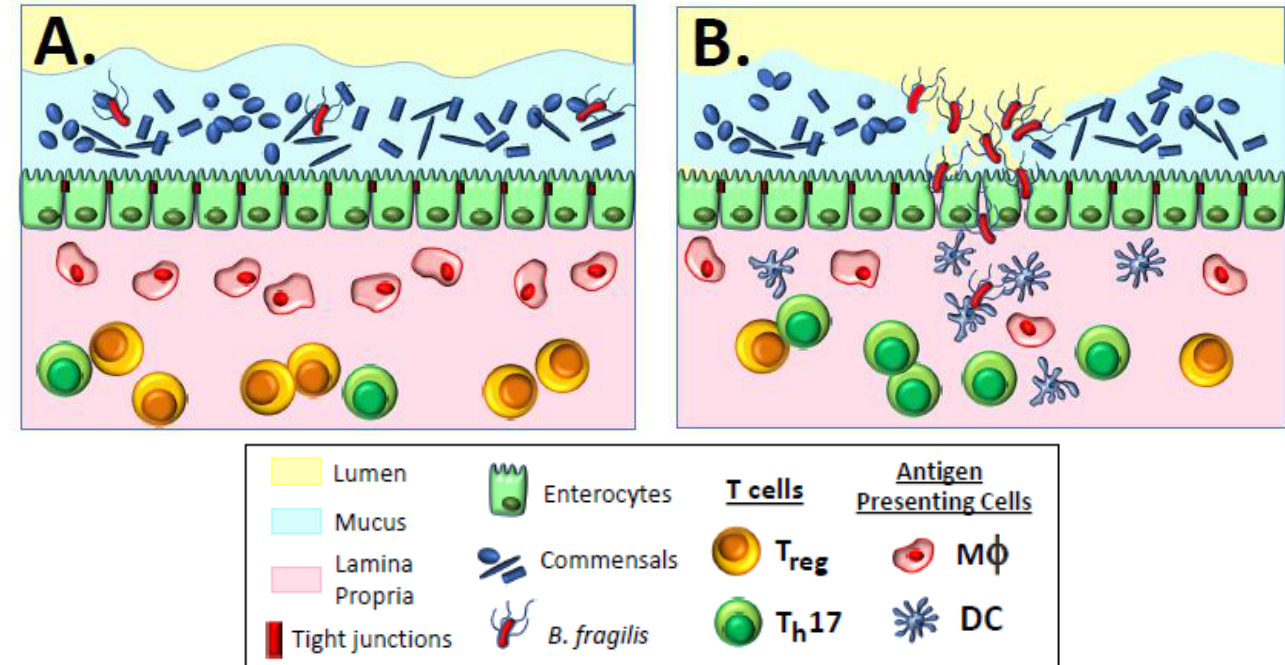
Figure 1. Homeostasis and inflammation in the gastrointestinal tract. ( A ) The steady state condition of the gastrointestinal immune system is tolerogenic, a baseline condition referred to as homeostasis, in which commensal bacteria are prevented from access to deep tissues but are not actively cleared from the gastrointestinal tract. During homeostasis, resident M2 macrophages maintain a low level of activity, and the T reg /T h 17 ratio favors T regs . During homeostasis, potential pathogens such as Enterotoxigenic Bacteroides fragilis (ETBF) are present as commensal organisms amongst the normal flora of the gastrointestinal tract. ( B ) Unknown environmental signals can activate secretion of a metalloprotease enterotoxin called Bacteroides fragilis toxin, or BFT, leading to loss of commensalism and damage of the colonic epithelial barrier through enzymatic cleavage of epithelial tight junctions. B. fragilis neuraminidase [24] breaks down the mucus layer to allow deeper penetration of both BFT and the pathogen itself. Invasion of the lamina propria triggers the activation of dendritic cells and shifts the balance of T reg /T h 17 to now favor T h 17 cells and an inflammatory response. Breach of the intestinal barrier can lead to secretory diarrhea, inflammatory colitis, and extraintestinal infections. For clarity, B cells, ILCs, and other potentially relevant immune cells have been omitted.